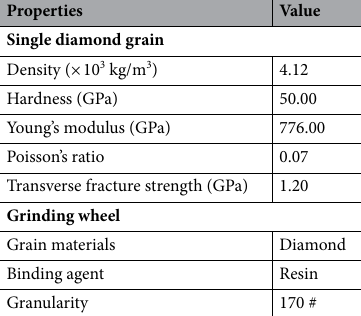
Table 1. Material properties of polycrystalline diamond single grain and grinding wheel.